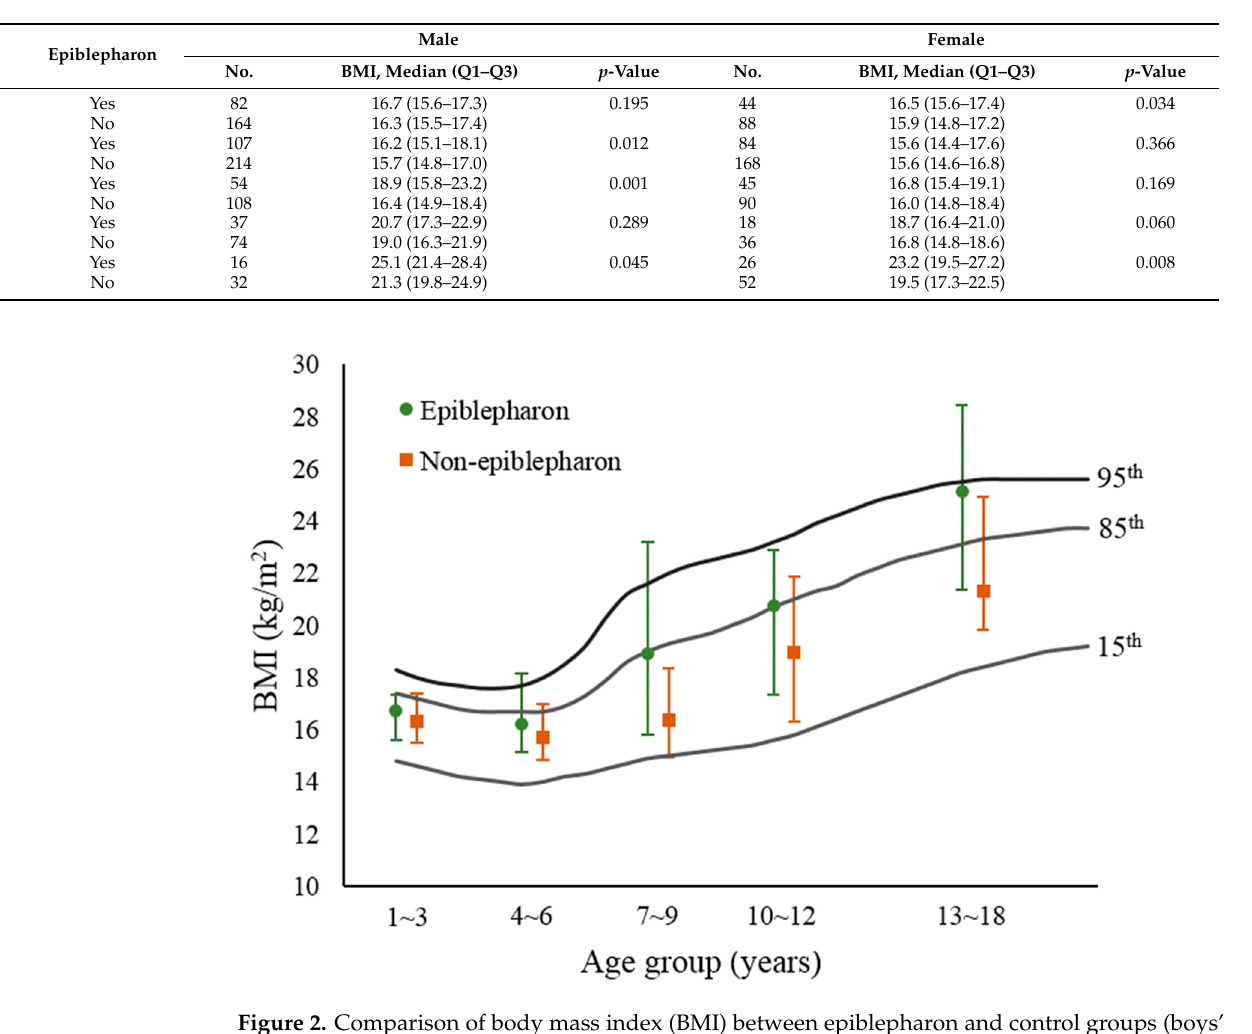
Table 2. The association between epiblepharon and body mass index (BMI) by sex and age.